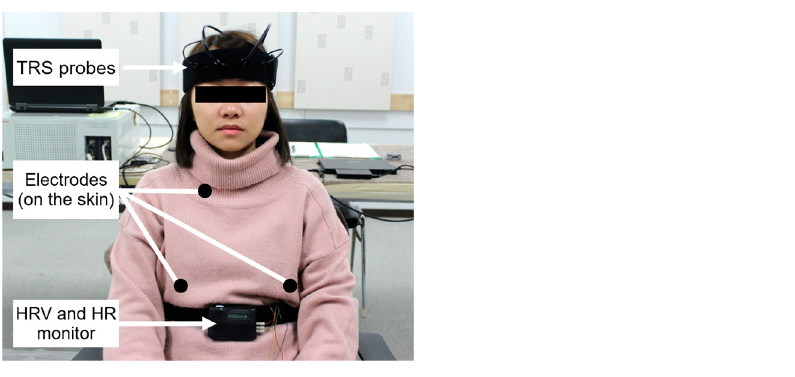
Figure 3. Assessment of physiological indicators. HRV (heart rate variability), HR (heart rate), and TRS (near-infrared time-resolved spectroscopy).